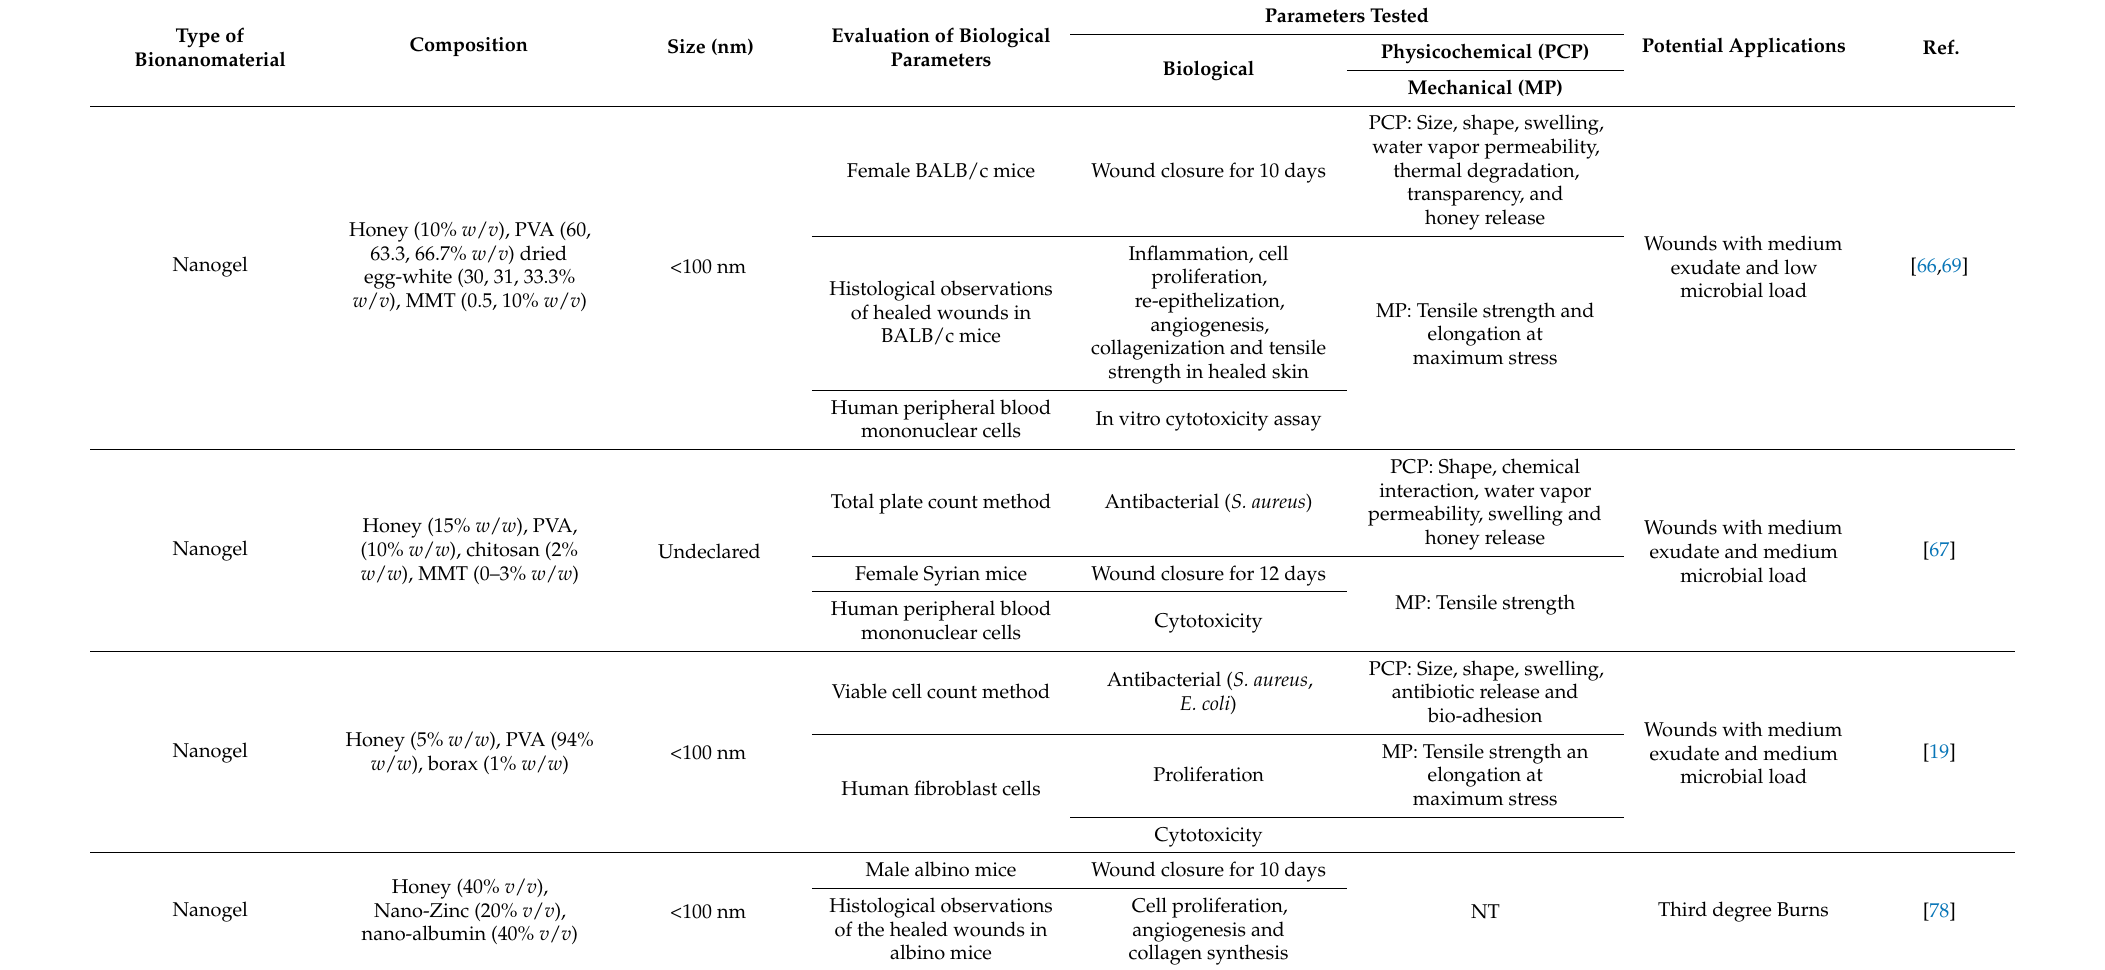
Table 1. Bionanomaterials based on honey. Type of bionanomaterial, composition, size, evaluation models, parameters tested (biological, physicochemical and mechanical), potential applications and